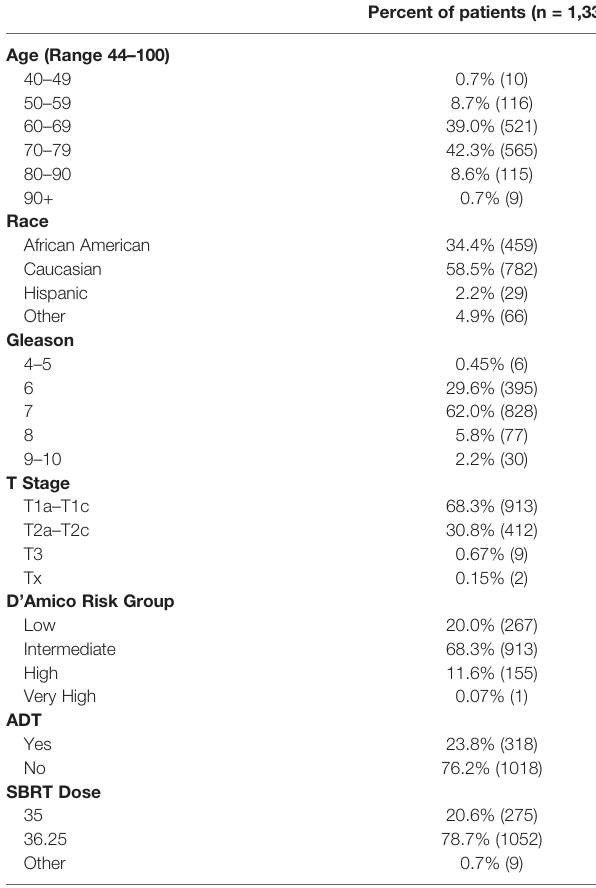
Percent of patients (n = 1,336)